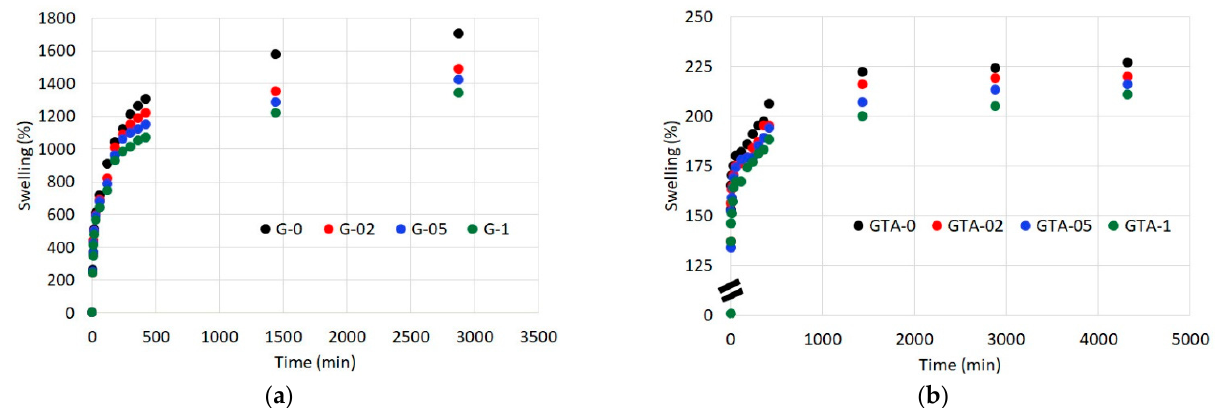
Figure 4. Swelling curves of ( a ) G films and ( b ) GTA films. Each value was determined in triplicate. Standard deviations are comprised of the size of the symbols.